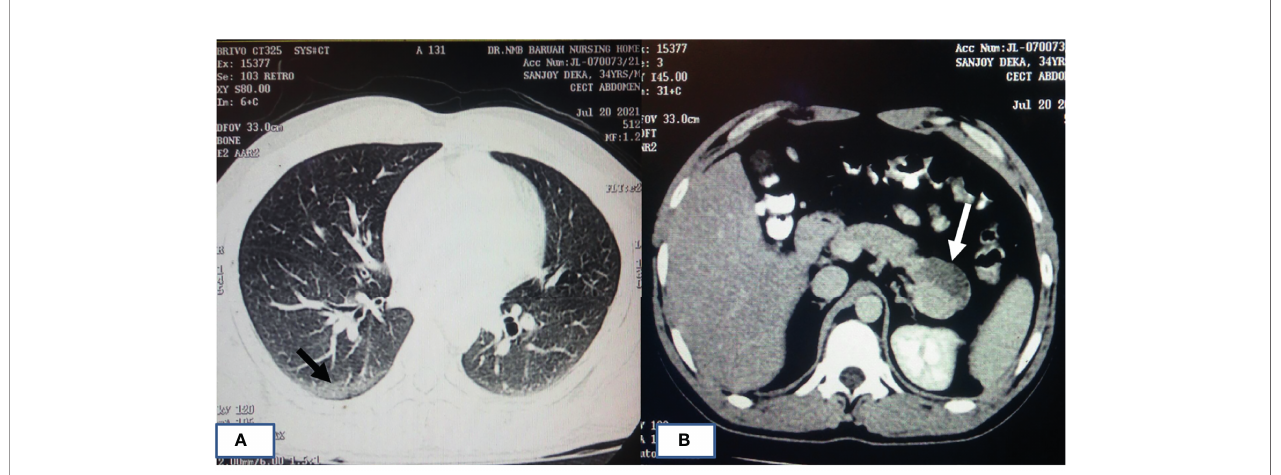
FIGURE 4 | HRCT chest of patients with COVID-19 pneumonia and acute pancreatitis. (A) A 34-year-old male who had cough and painful abdomen showing typical imaging manifestations of COVID-19 pneumonia in the peripheral basal segment of right lower lobe (black arrow). (B) CECT abdomen image of same patient showing hypodensity in the tail of pancreas (white arrow) suggestive of acute necrotizing pancreatitis.